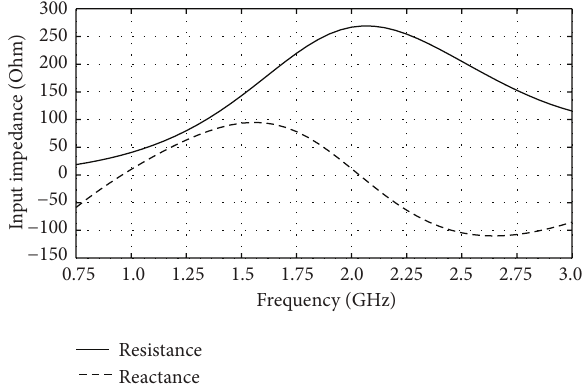
Figure 17: Variation of the bowtie antenna impedance with the frequency; 𝐿 𝐵 = 9.525 cm, 𝑊 𝐵 = 4.5 mm, and 𝜃 𝑓 = 45 ∘